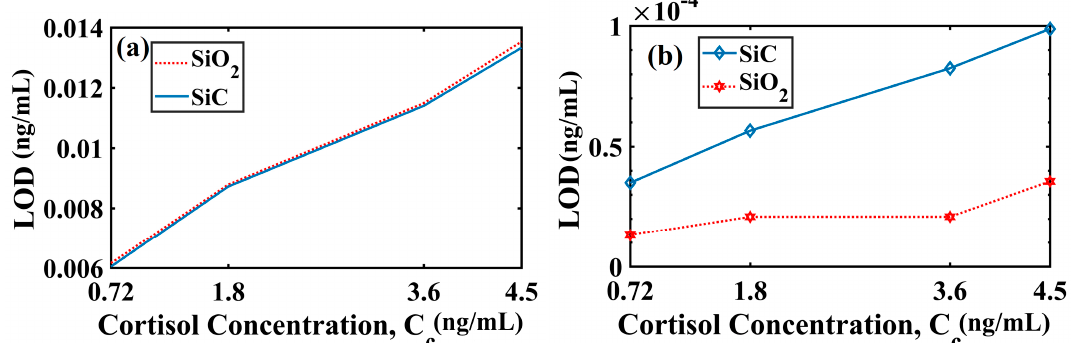
Figure 4. Limit of detection (LOD) variation with cortisol concentration (solution of cortisol-conjugated BSA) in the case of the ( a ) angular interrogation mode and ( b ) intensity interrogation mode for SiO 2 and SiC grating based configurations. The reference sample was C c = 0.36 ng / mL. Here, d 1 / d = 0.5, t Ag = 47.10 nm (for SiO 2 ) and t Ag = 38.30 nm (for SiC) and λ = 830 nm.